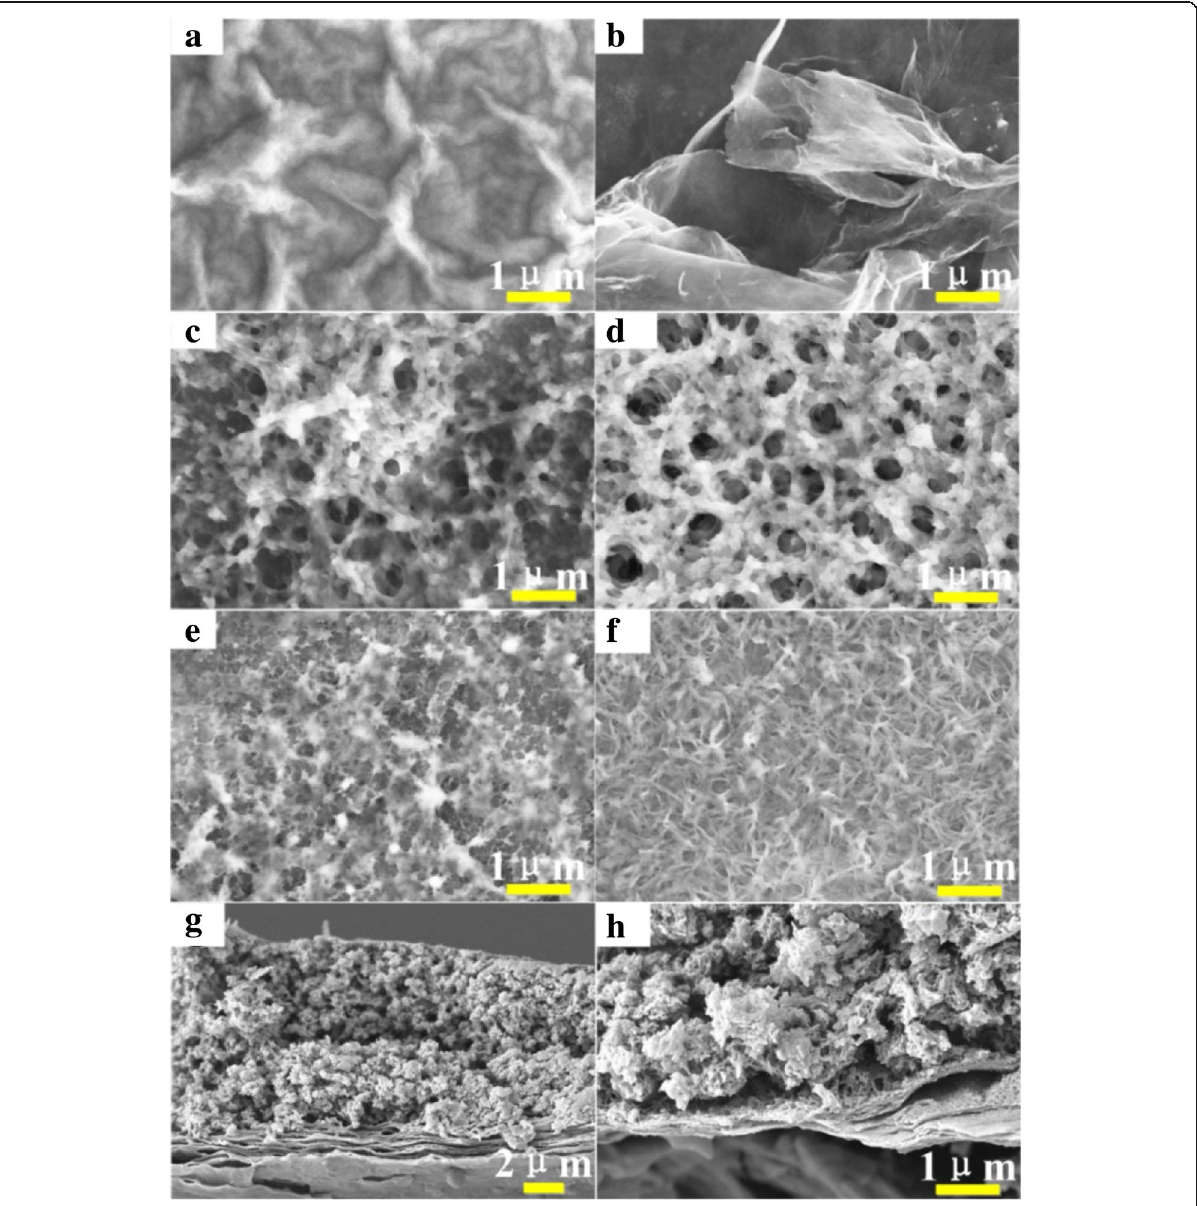
Fig. 2 The typical SEM images of top view for a GO, b rGO, c rGO/PEDOT-30, d rGO/PEDOT-50, e rGO/PEDOT-80, and f rGO/PEDOT-100. The cross-section images g and h of